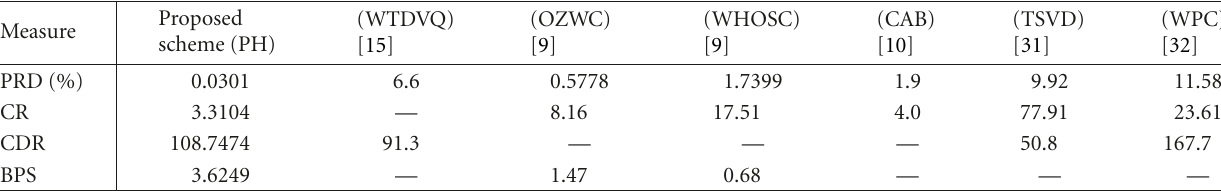
Table 8: Record MIT-ADB 100: performance comparison results with di ff erent ECG compression methods. PH denotes MLP predictor in the first stage and Hu ff man encoder in the second stage. WTDVQ denotes wavelet transform coding using dynamic vector quantization.